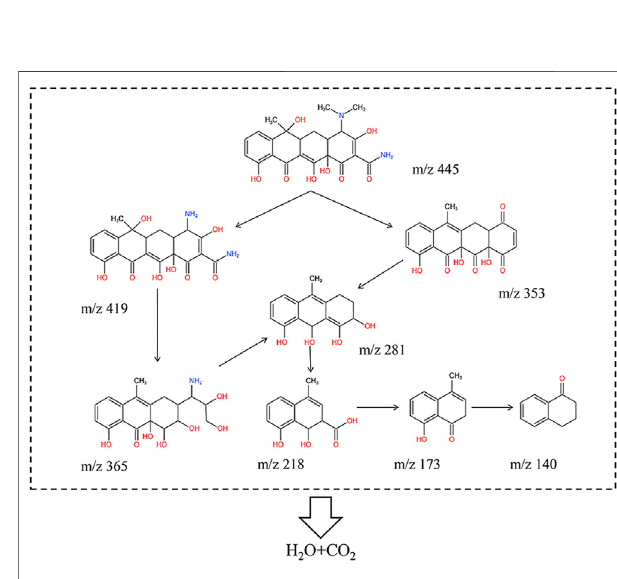
FIGURE 11 | Active species trapping experiment of ZF-Sep-11. Reaction conditions (TCH) (cid:1) 20 mg/L [catalysts] (cid:1) 1.0 g/L (H 2 O 2 ) (cid:1) 1 mM